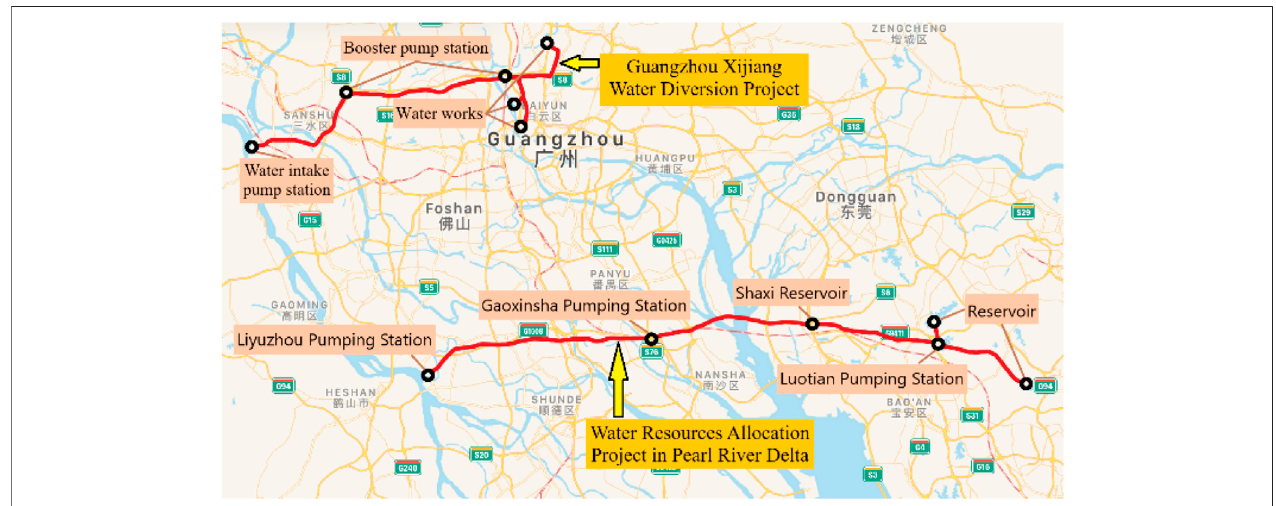
FIGURE 1 | New composite lining water conveyance